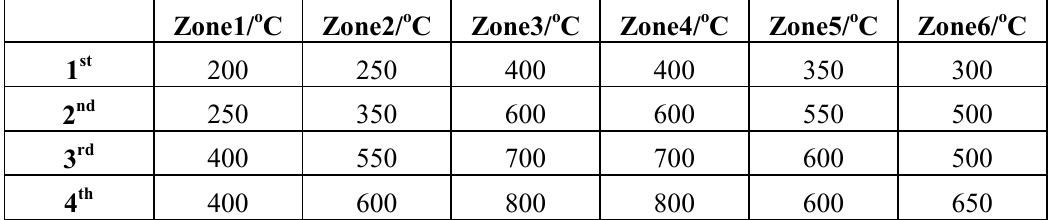
Table 1. Four different oven settings for sintering in air.